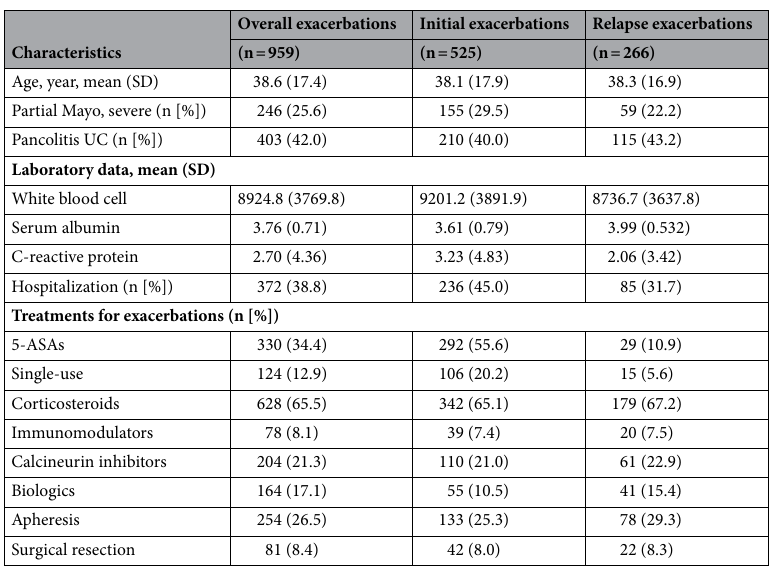
Table 2. Clinical characteristics and treatments in patients with moderate to severe UC